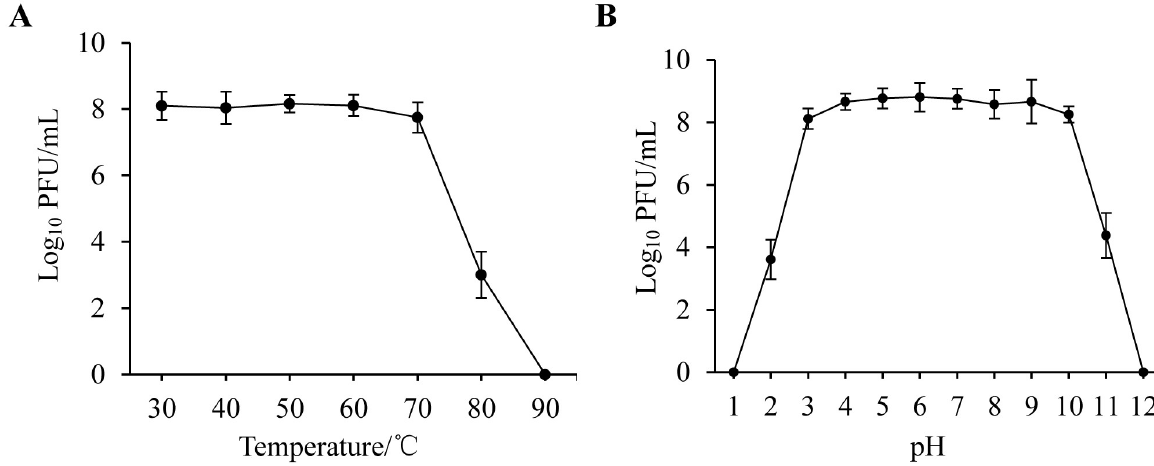
Fig 2. The effects of different conditions on PSDA-2 activity. (A) Temperature, (B) pH.